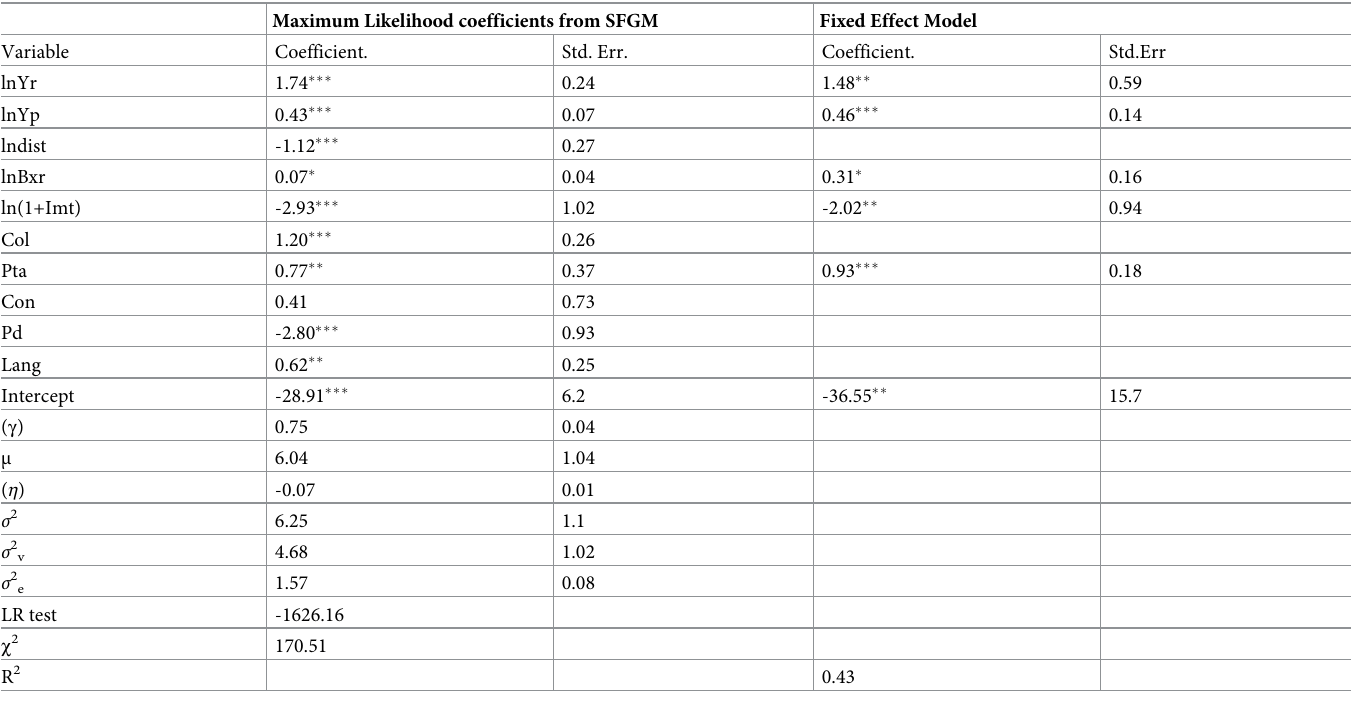
Table 4. Gravity model regression